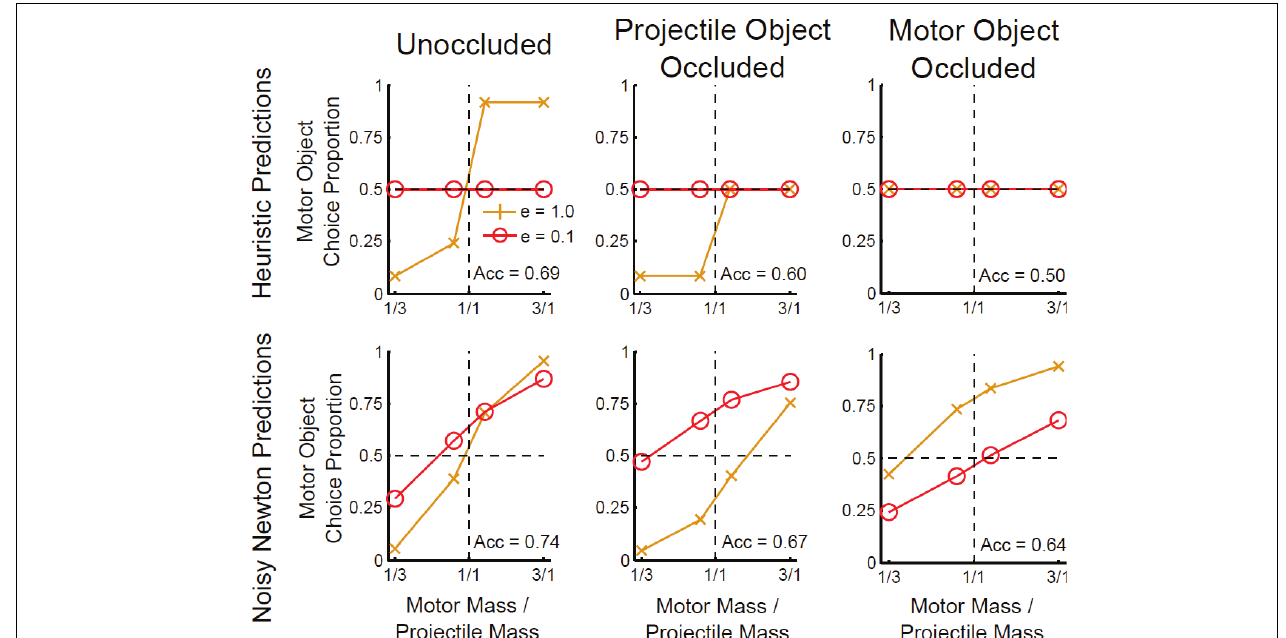
FIGURE 2 | Predictions of the heuristic and noisy Newton models for different types of occlusion conditions in Experiment 1. The horizontal axis is the mass ratio of the motor object to the projectile object. The vertical axis is the proportion of trials on which participants decided the motor object